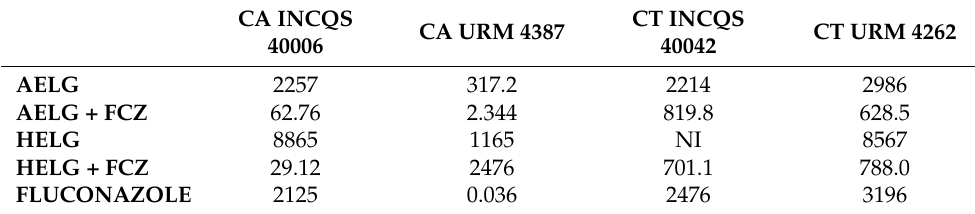
Table 2. IC 50 of the AELG and HELG against different strains of Candida